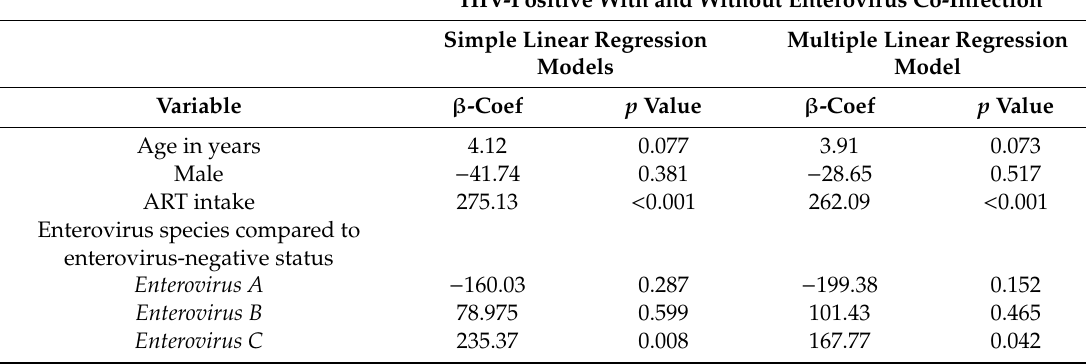
Table 3. Factors associated with increased CD4 + T cell count in HIV-positive participants with and without enterovirus